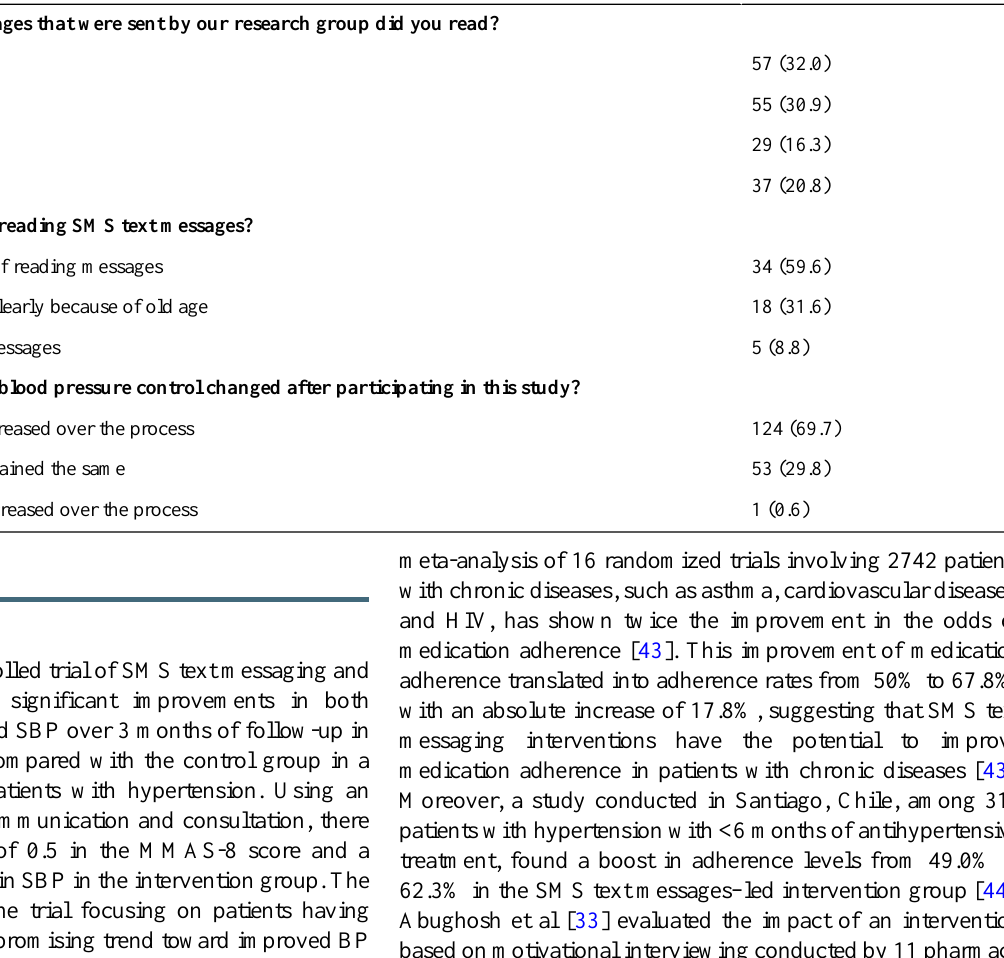
Table 7. Text acceptability after the 3-month intervention (n=178). How many SMS text messages that were sent by our research group did you